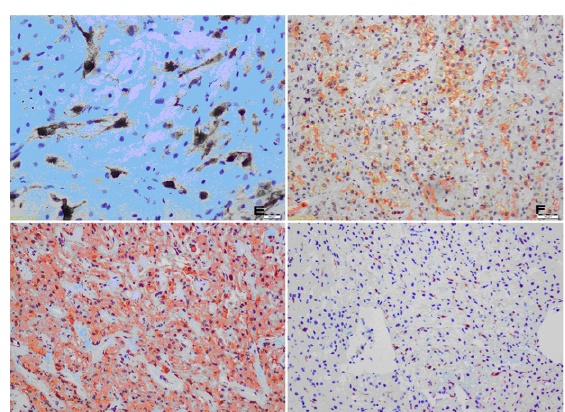
Figure 3. Many tumor cells showed cytoplasmic staining for HMB- 45 (E); S-100 protein (F); Vimentin (G); rare cells are CD-117 positive